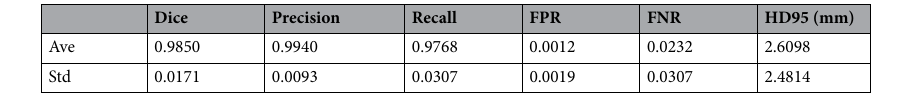
Table 2. Overall performance of skull stripping in the testing